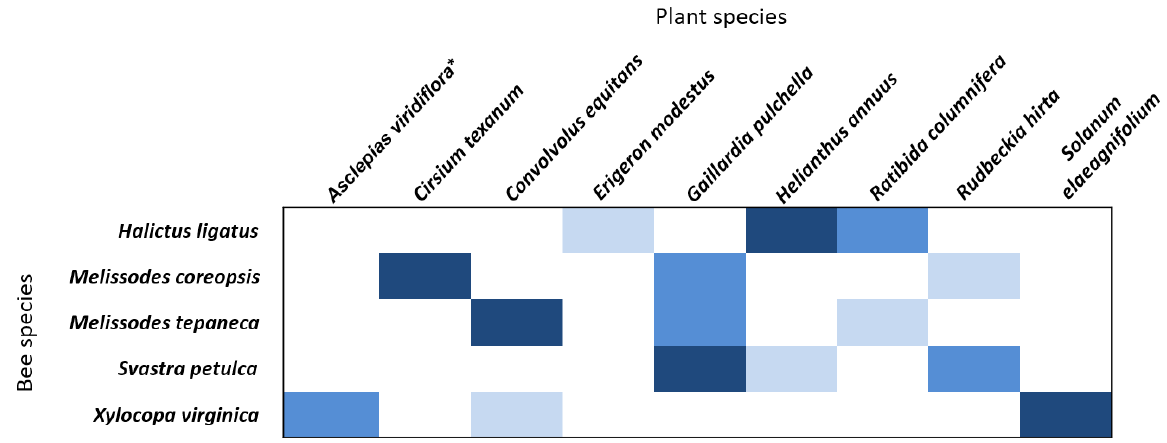
Figure 2. Results of the pollen preference analysis for the five most commonly occurring bee species. The color gradient represents preference with darker colors indicating higher preference and lighter colors indicating lower preference. *Denotes plants that are used solely for nectaring and not for pollen collection.